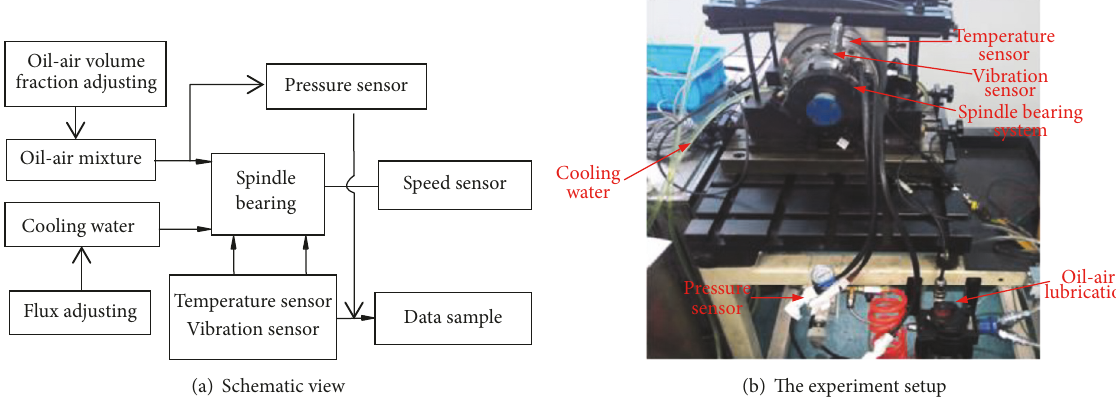
Figure 12: High speed spindle bearing equipment under oil-air